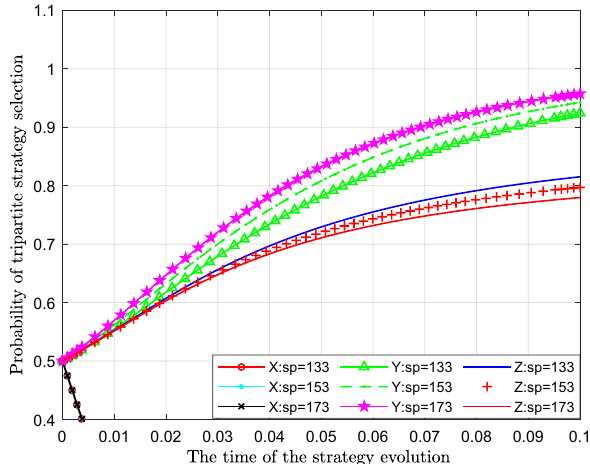
Figure 6. Effect of changes in economic compensation obtained from sewage